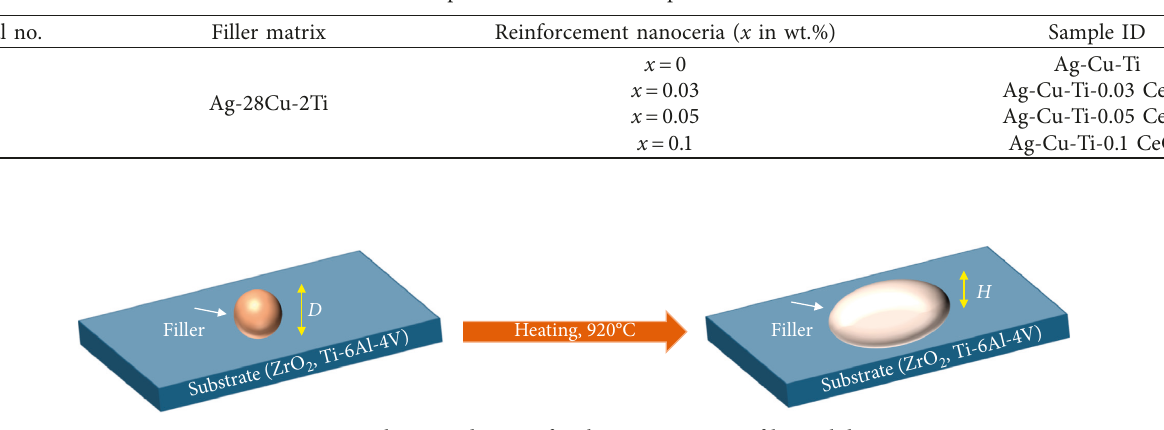
Table 1: Composition of various composite fillers used.